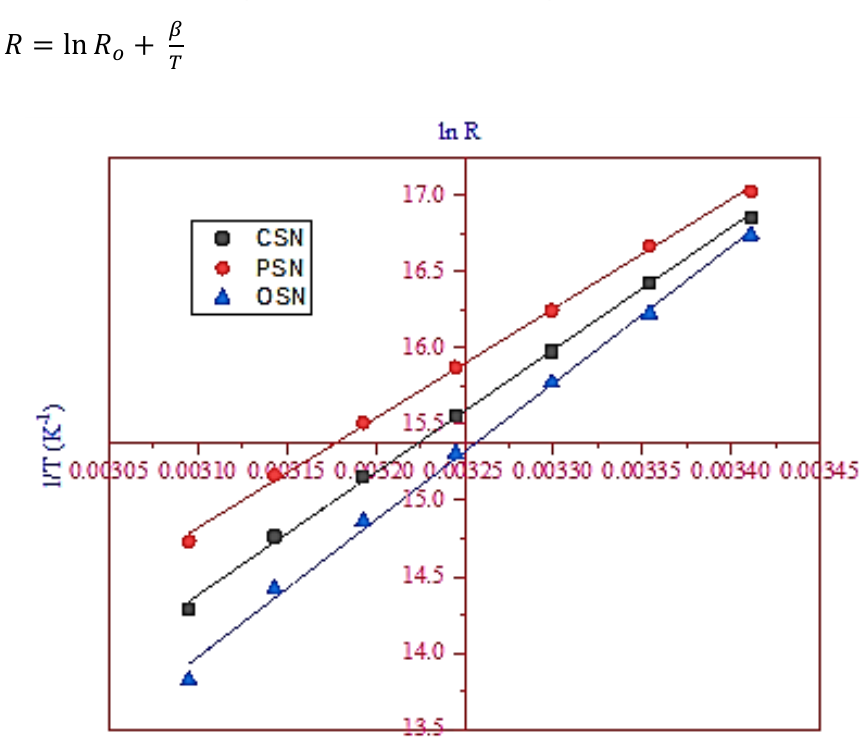
Figure 5. Plot of ln R against